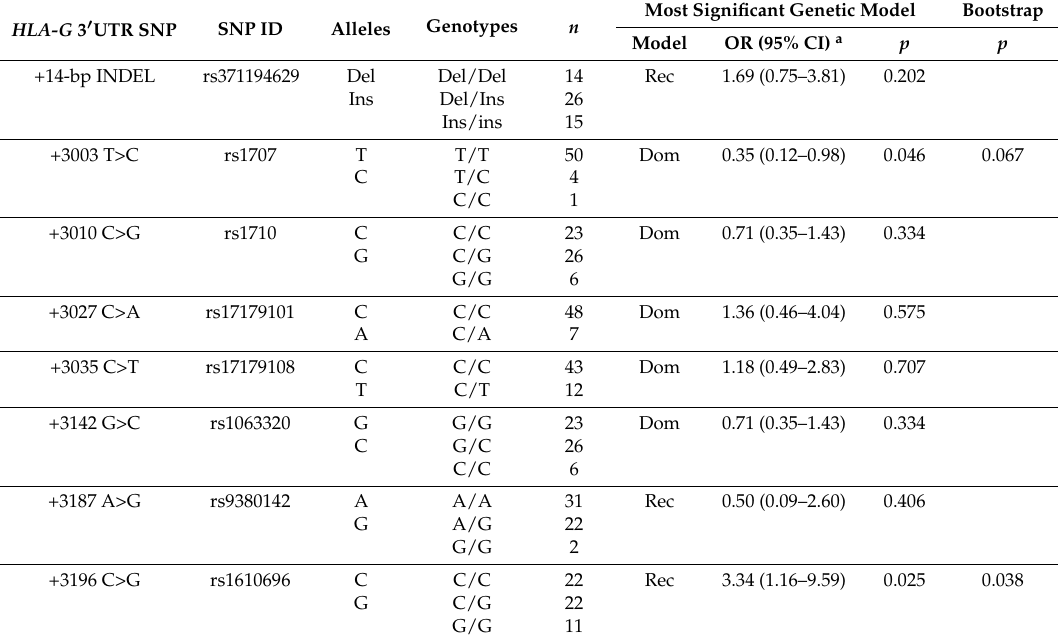
Table 3. Associations between HLA-G 3 (cid:48) UTR SNPs and G3-4 hematological toxicity.